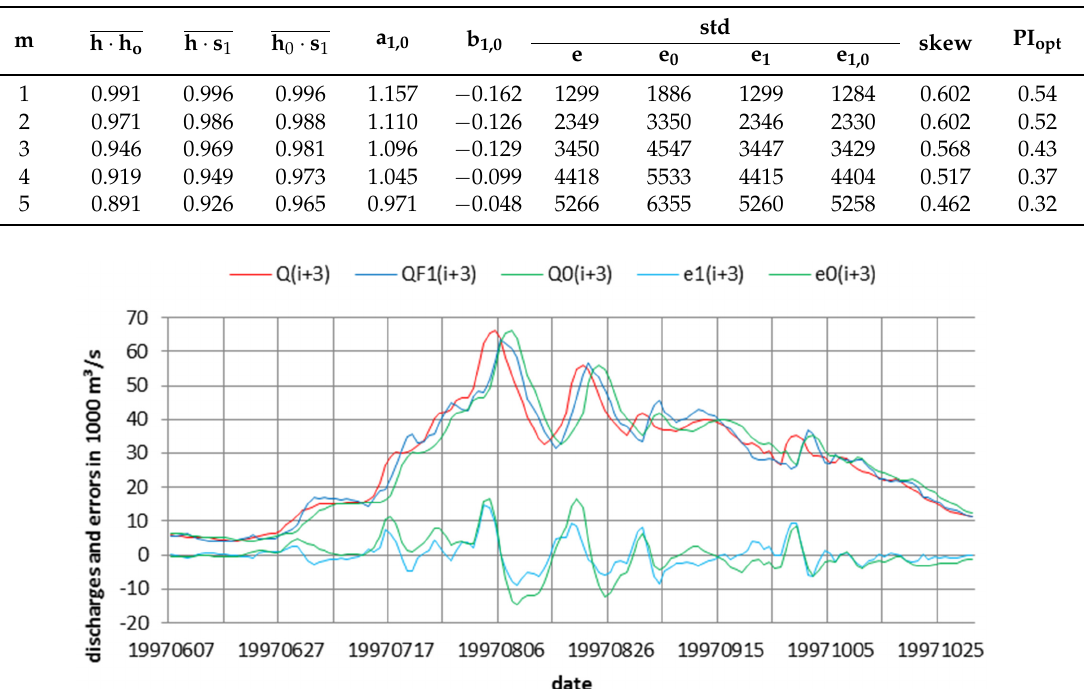
Table 1. Results from combinations of model 1 and persistence model 0. Column 7 lists standard